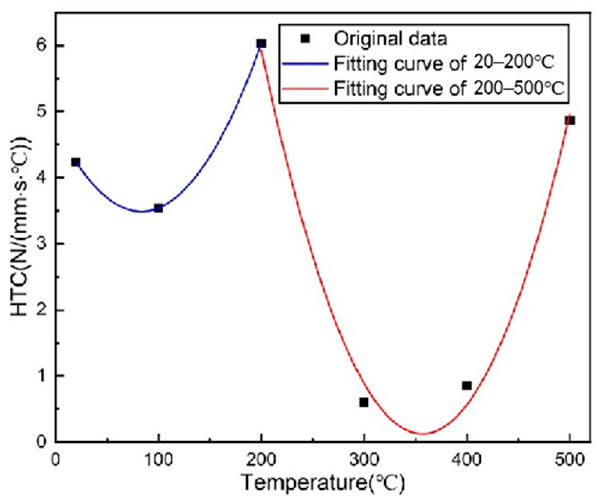
Figure 10. Fitting curve of heat transfer coefficient during quenching. Table 6. Heat transfer coefficient values obtained during the fifth